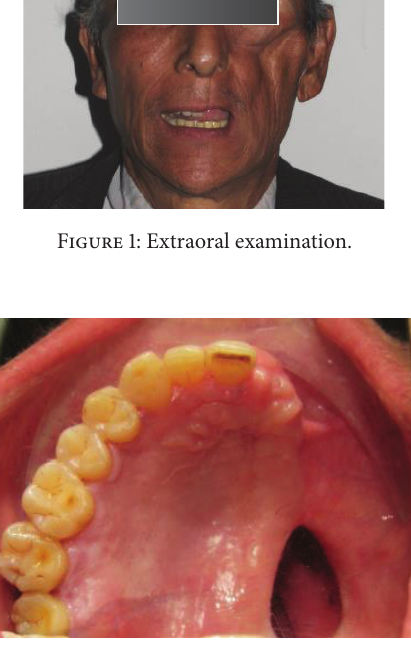
Figure 2: Intraoral examination of defect area.